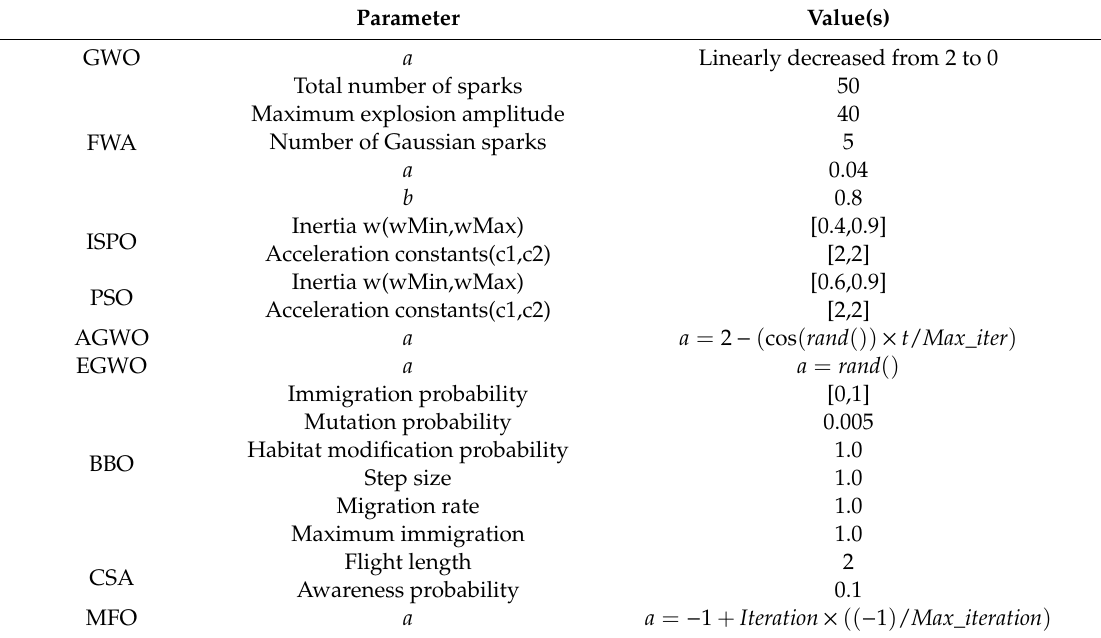
Table 1. Parameter